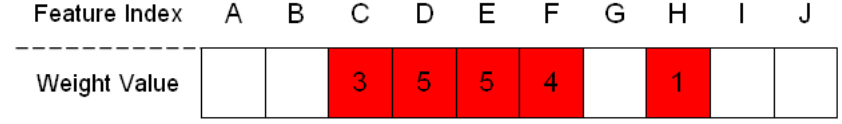
Figure 6. Example of how to calculate the weight values of selected features.